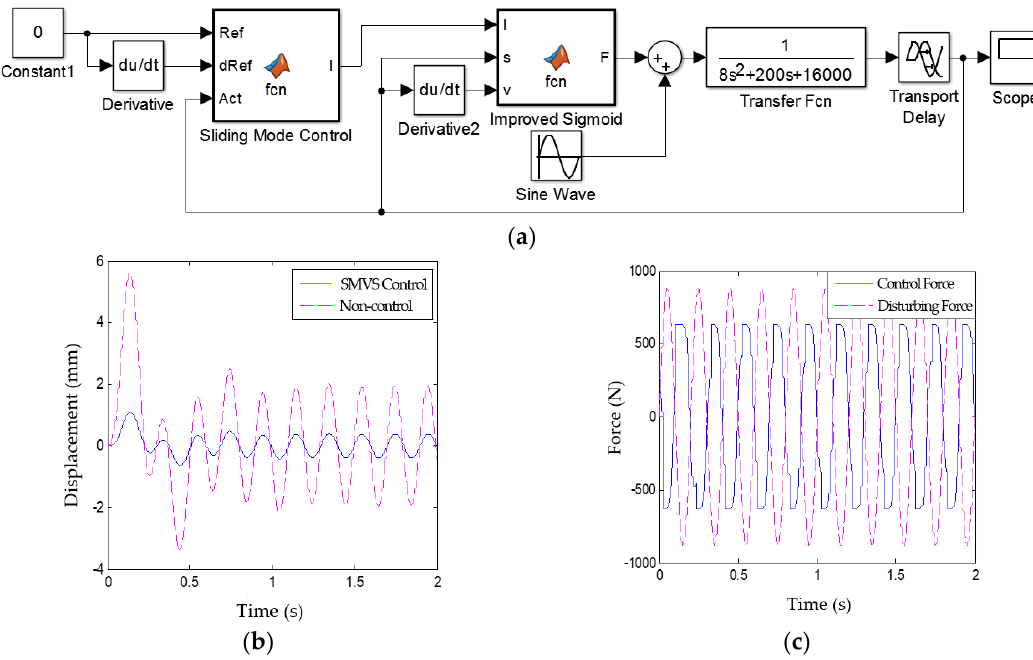
Figure 9. Simulation of sliding-mode-variable-structure (SMVS) pipeline vibration control system: ( a ) Sliding-mode-variable-structure (SMVS) simulation model; ( b ) Vibration displacement response; ( c ) Control force and disturbance dynamics curve